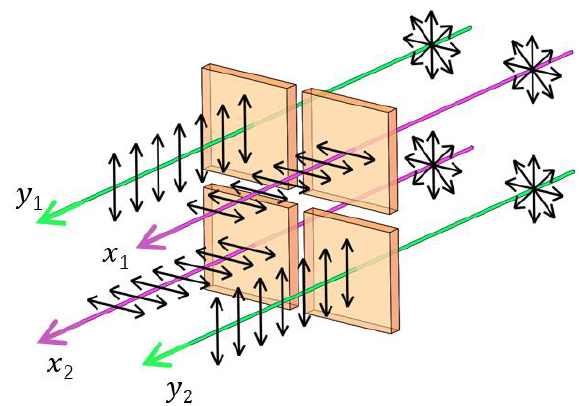
Figure 2. Polarizing directions of the four imaging beams passing through polarizers.